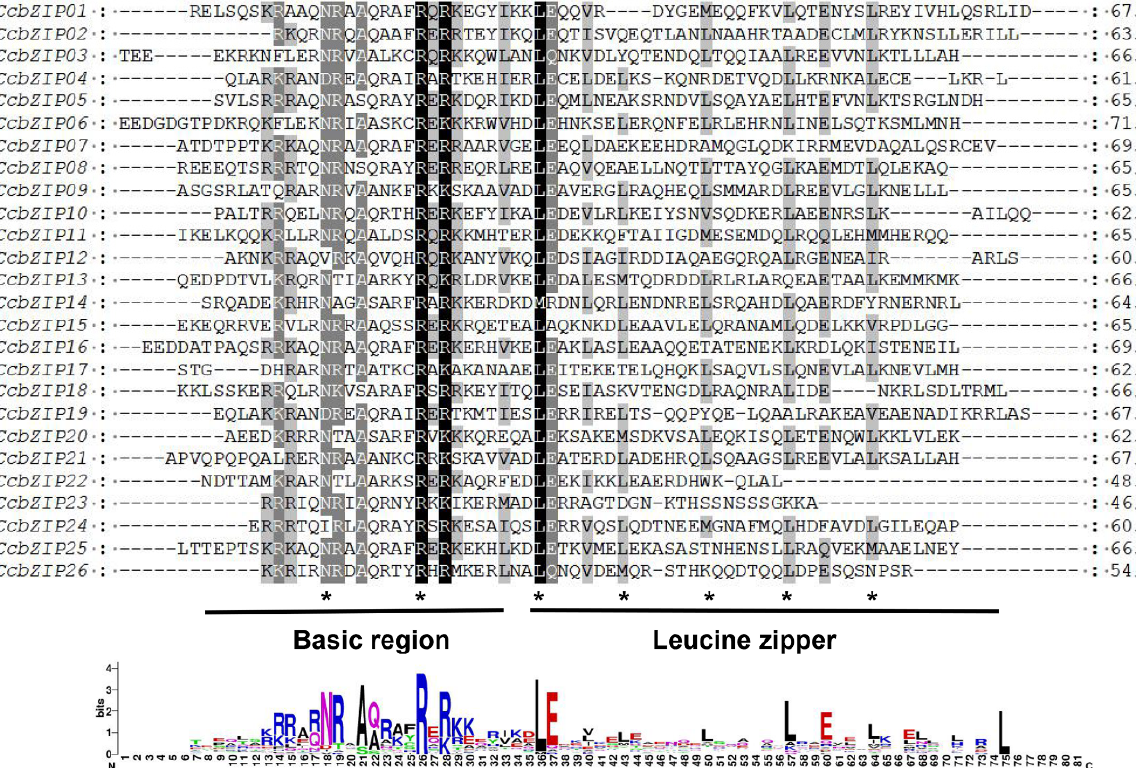
Figure 1. Multiple sequence alignment of bZIP domain in CcbZIP genes. Amino acid sequences of bZIP domain were aligned by MUSCLE V3.8.1551 with minor modifications. Black, medium gray, and light gray indicate the conserved percent of 100%, >80%, and >60%, respectively. The short, black lines in the middle represent a typical bZIP domain; asterisks show the conserved amino acids of bZIP domains. The bottom part is the sequence logo formed by bZIP domain from CcbZIP genes, and the larger letters of the amino acid residues, the more frequently they appear at the same